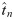
Modeling linear gradient in coupling with constant excitability νn = 0.2 for all nodes.Panel a shows the scaled mean recruitment times t^n extracted from the experimental data, with the simulation results with gradient in coupling weights (A0, δA) = (0.08, 0.005) indicated by the red stars in b and c; compare to Fig 4. The red stars lie in the region of (A0, δA) parameter space that both minimizes d and satisfies PV ≈ 0.86.